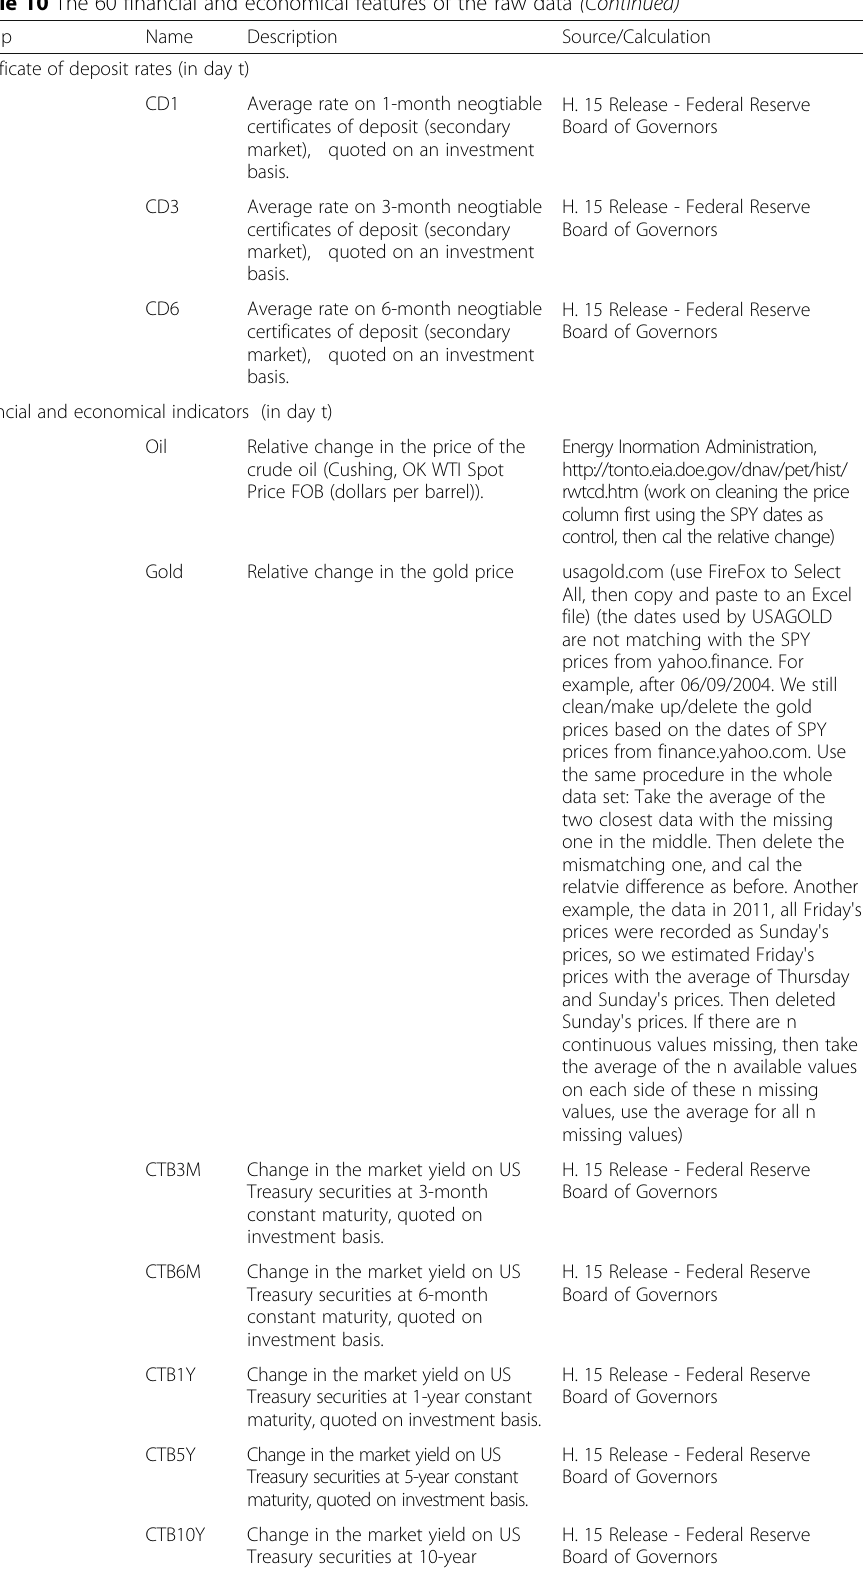
Table 10 The 60 financial and economical features of the raw data (Continued)